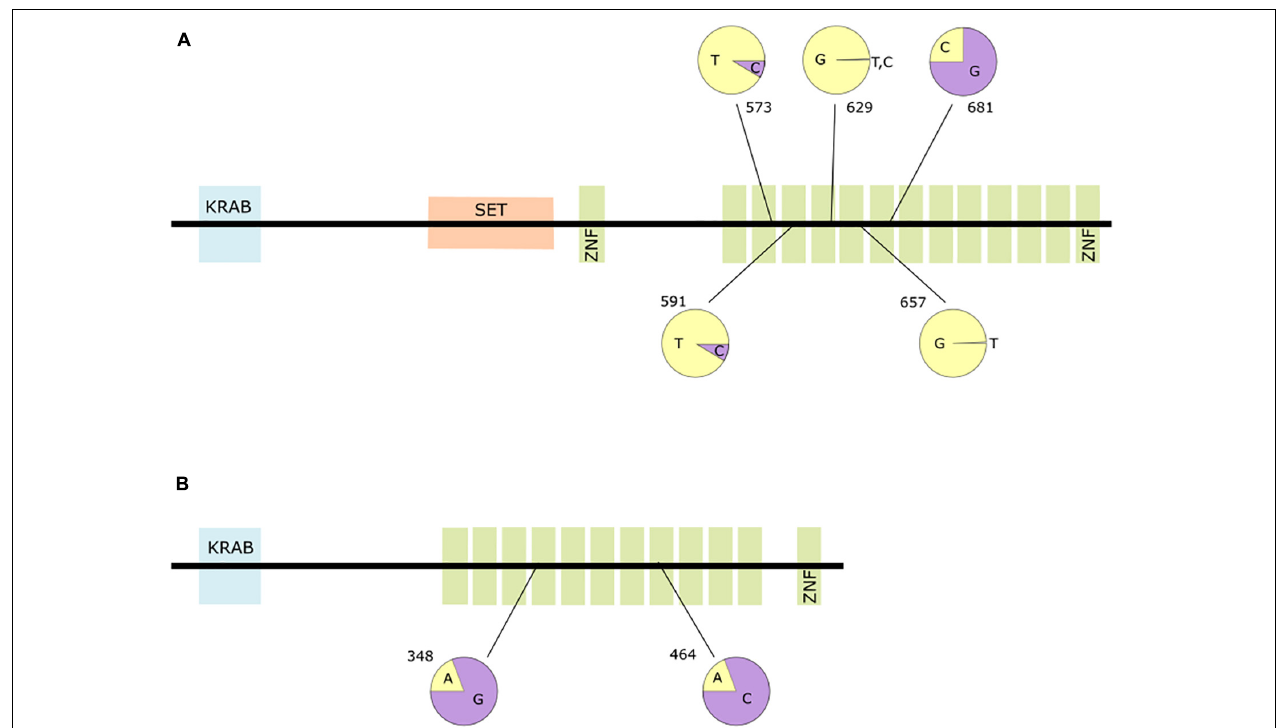
FIGURE 4 | Domain structures of (A) PRDM9; (B) ZNF860. Green boxes indicate ZNF domains. The pie charts represent frequencies of the positively selected (yellow) and ancestral variants (purple) for the respective positions within the